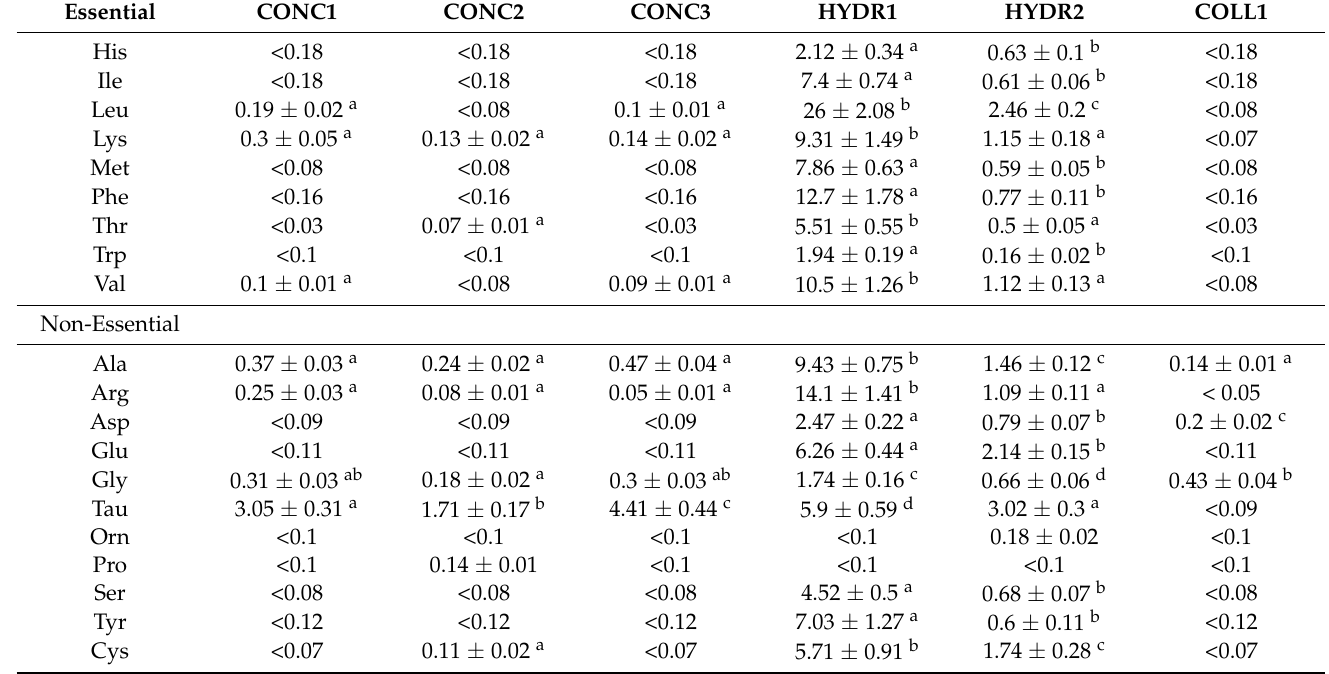
Table 4. Free amino acids ( µ g/g) in commercial fish protein concentrates, hydrolysates, and hy- drolyzed collagen with mean and standard deviation of three replicate measurements. Different letters within the same row indicate a statistically significant difference with ANOVA post hoc pair comparison ( p <